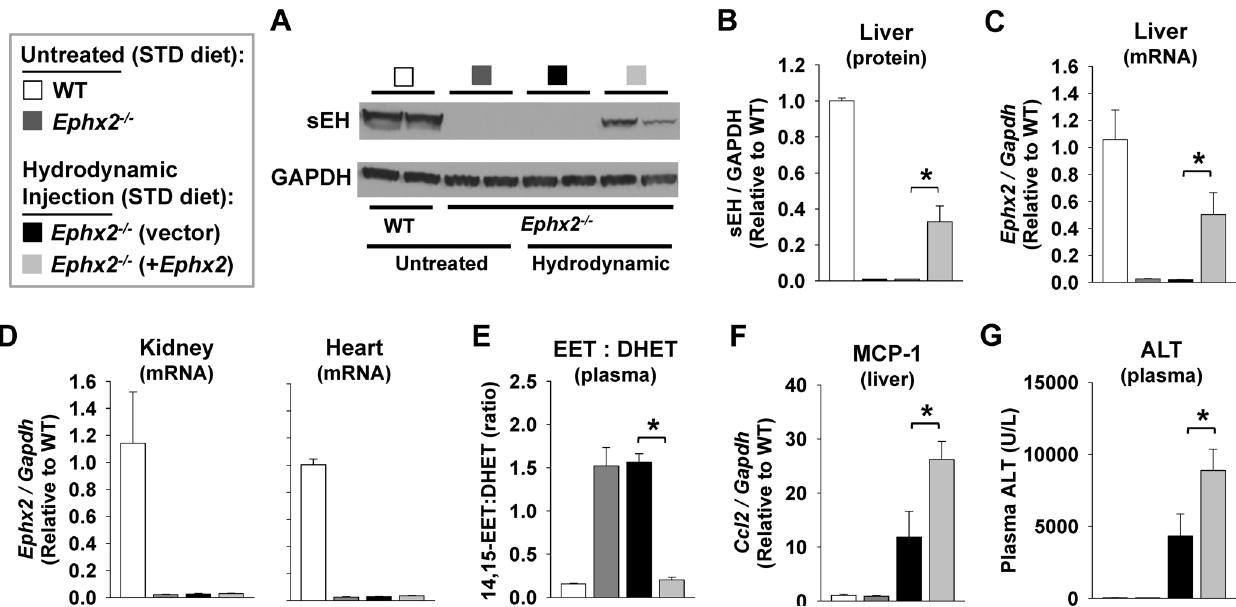
Figure 4. Hydrodynamic delivery of Ephx2 to Ephx2 2 / 2 mice. Ephx2 2 / 2 mice were administered plasmid DNA (empty vector [control] or vector containing murine Ephx2 ) by hydrodynamic injection (9% of body weight over 5 seconds). All mice were fed with a standard chow diet, and liver tissue and plasma were harvested 18 hours following injection. A parallel group of untreated WT and Ephx2 2 / 2 mice were included for comparison (n=4 per group). (A) A representative immunoblot in liver lysates and (B) corresponding densitometry analysis demonstrate partial restoration of hepatic sEH protein expression in Ephx2 2 / 2 mice. (C) Quantitative RT-PCR demonstrates partial restoration of Ephx2 mRNA levels in liver. (D) In contrast, no detectable increase in Ephx2 mRNA levels was observed in either kidney or heart tissue. (E) Hydrodynamic delivery of Ephx2 significantly lowered the plasma 14,15-EET:DHET ratio (biomarker of sEH metabolic function [lower ratio indicative of higher function]) to a level equivalent with untreated WT mice. Hydrodynamic injection of empty vector markedly increased (F) hepatic Ccl2 mRNA levels and (G) plasma ALT levels compared to untreated controls, and induction of these biomarkers of hepatic inflammation and injury were significantly increased in the presence of the Ephx2 transgene. *P , 0.05 vs. Ephx2 2 / 2 (vector)